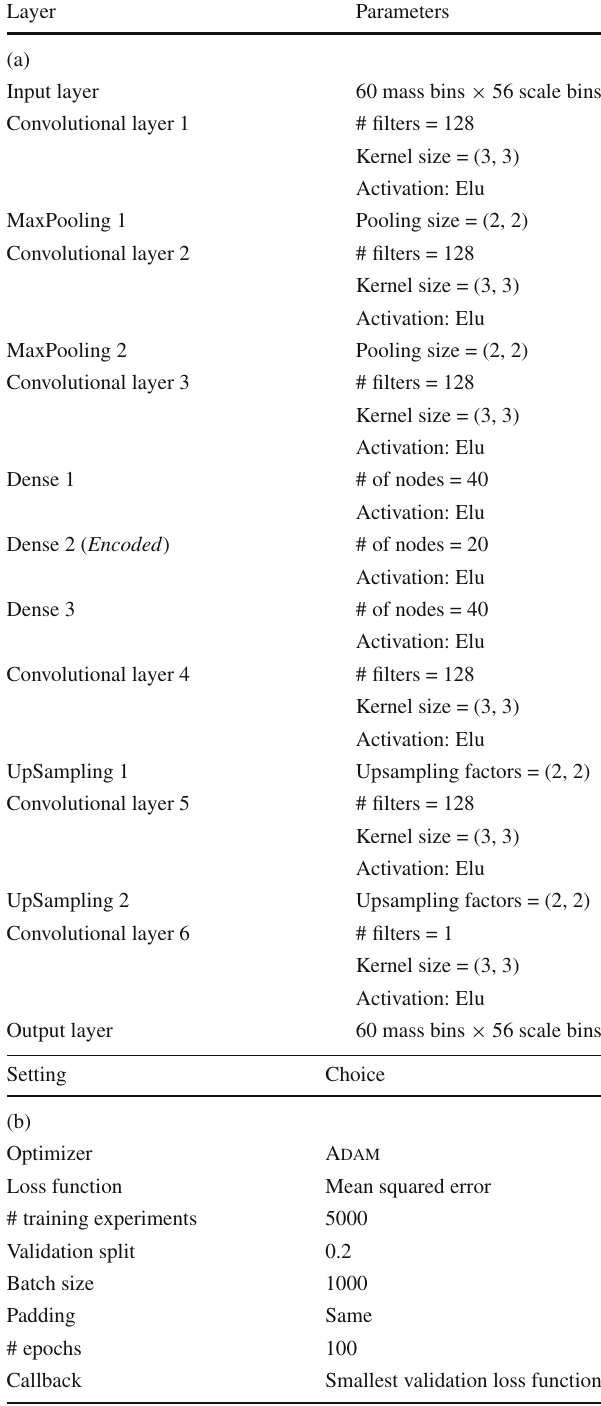
Table 3 (a) Structure of the convolutional neural network for the autoencoder. (b) Training parameters. All parameters not specified in these tables are left at their default Keras